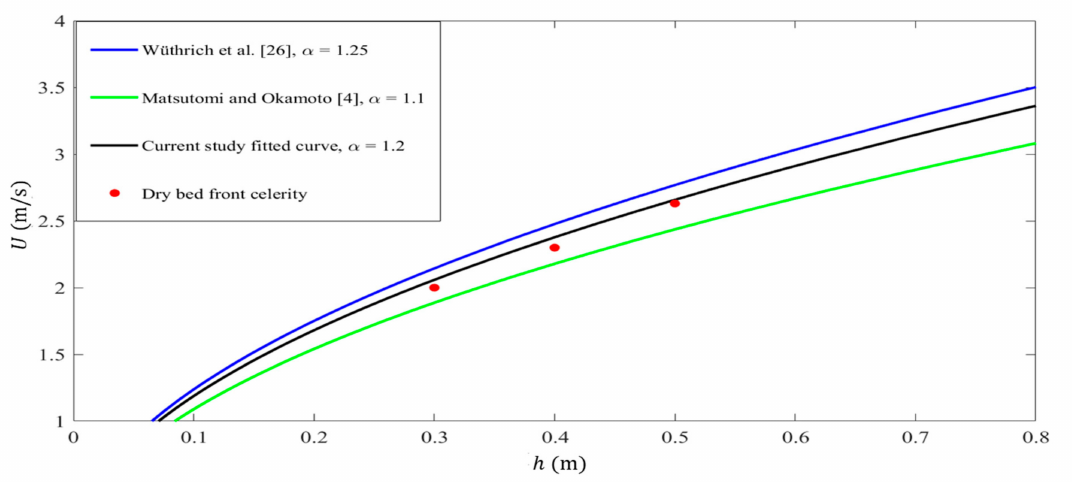
Figure 7. Comparison between the front celerity for dry bed in this study and previous studies.